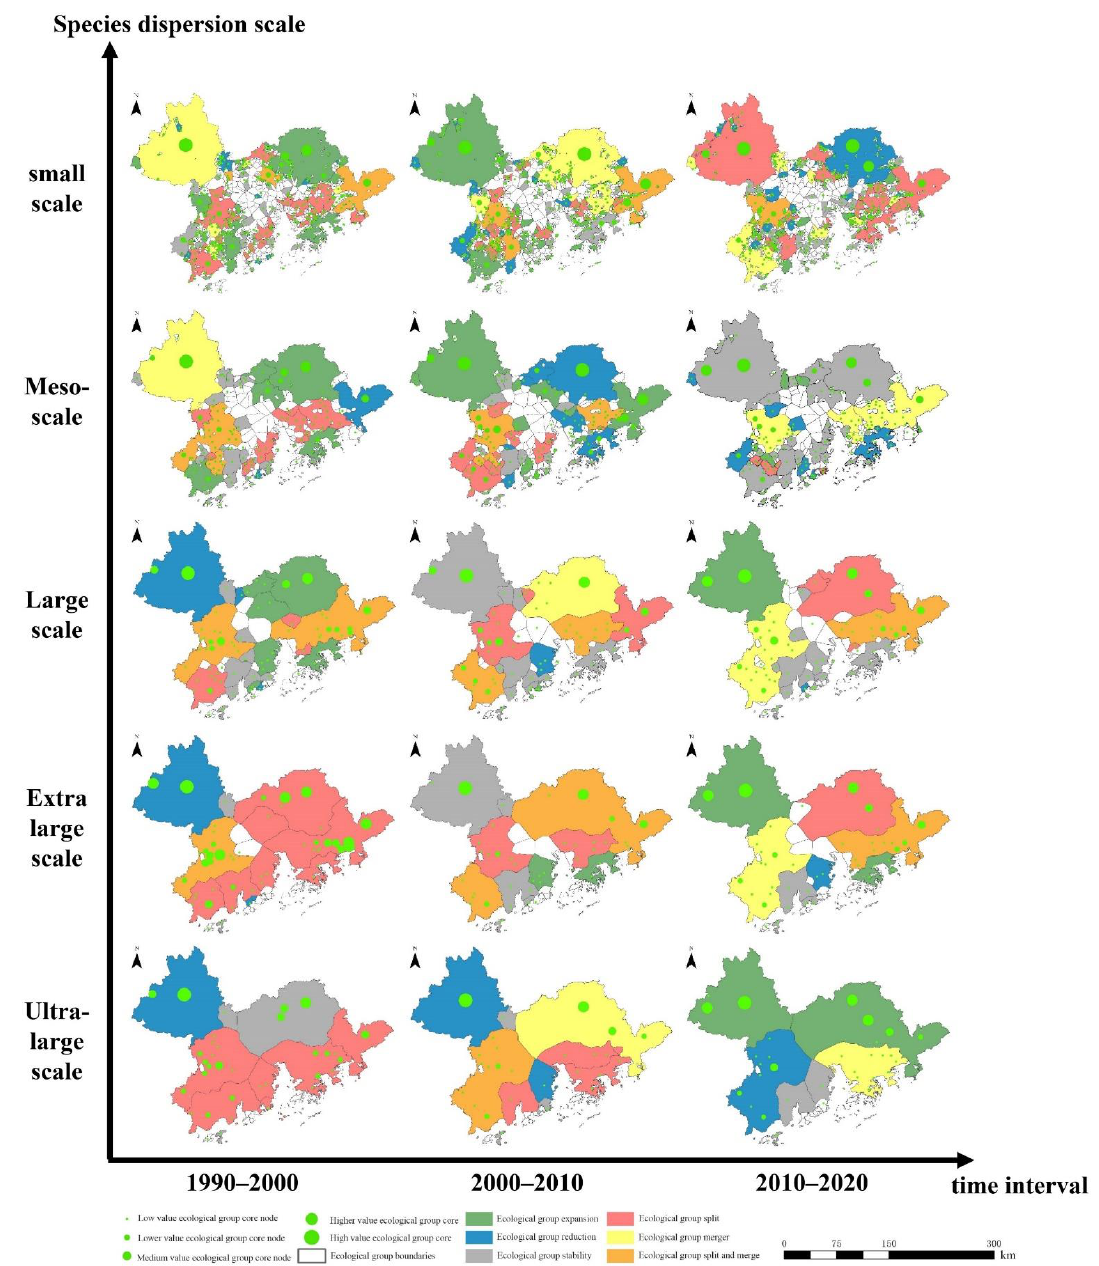
Figure 10. Distribution of evolutionary events of various ecological groups.